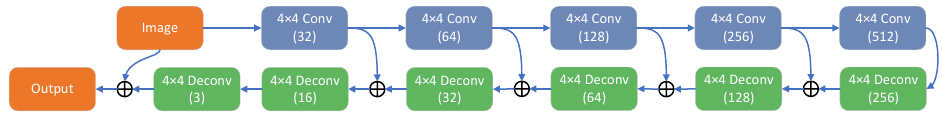
Figure 4. Structure of SR network.